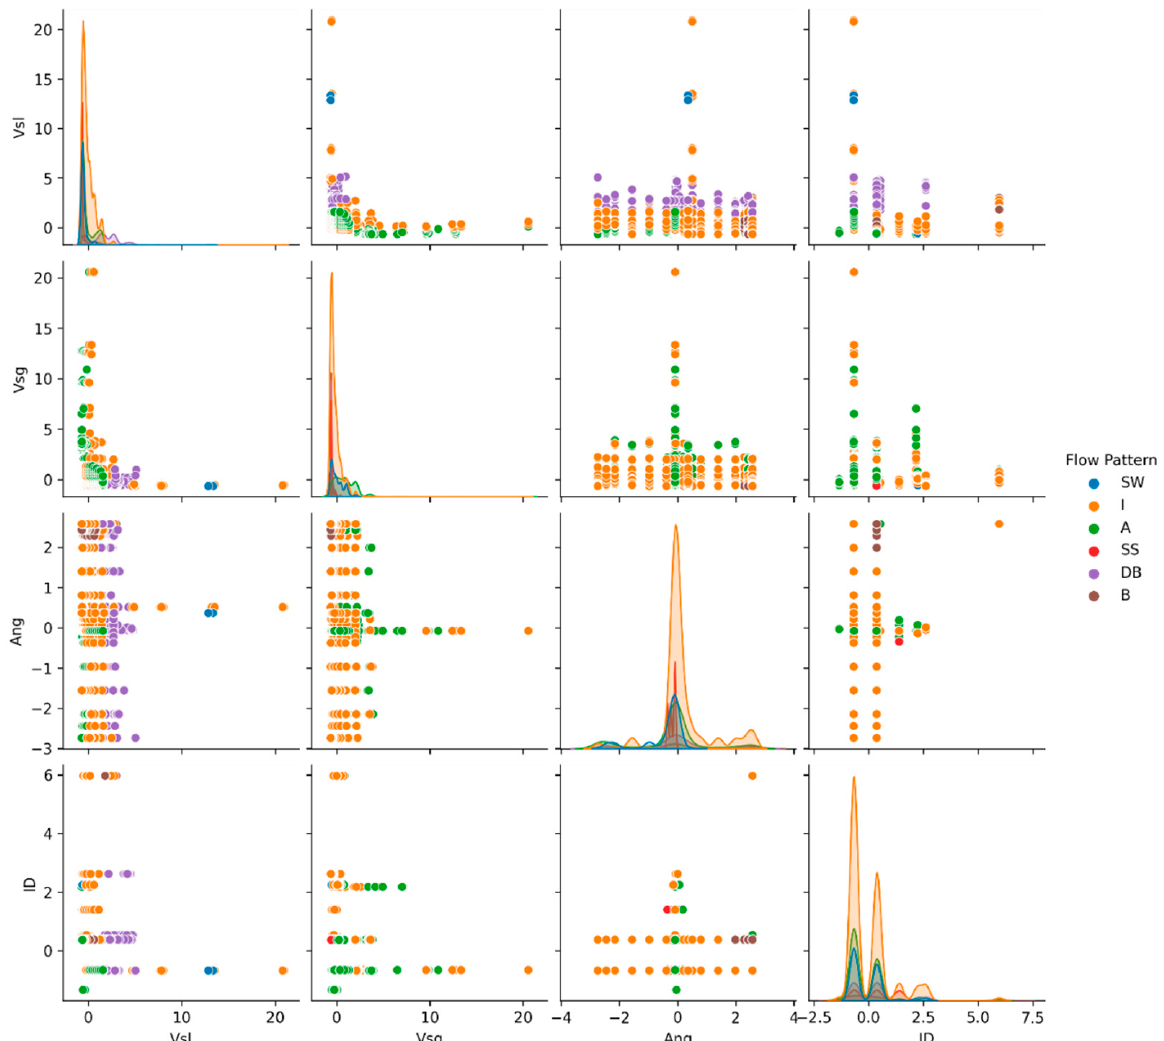
Figure 5. Pair-plot for exploratory data analysis of top four feature variables (V sl , V sg , Ang, and ID).